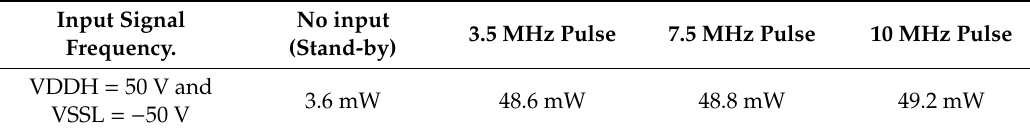
Table 2. Measured power consumption of the ultrasound pulse driver per channel in the excitation mode (excitation rate = 1% of the pulse repetitive frequency).